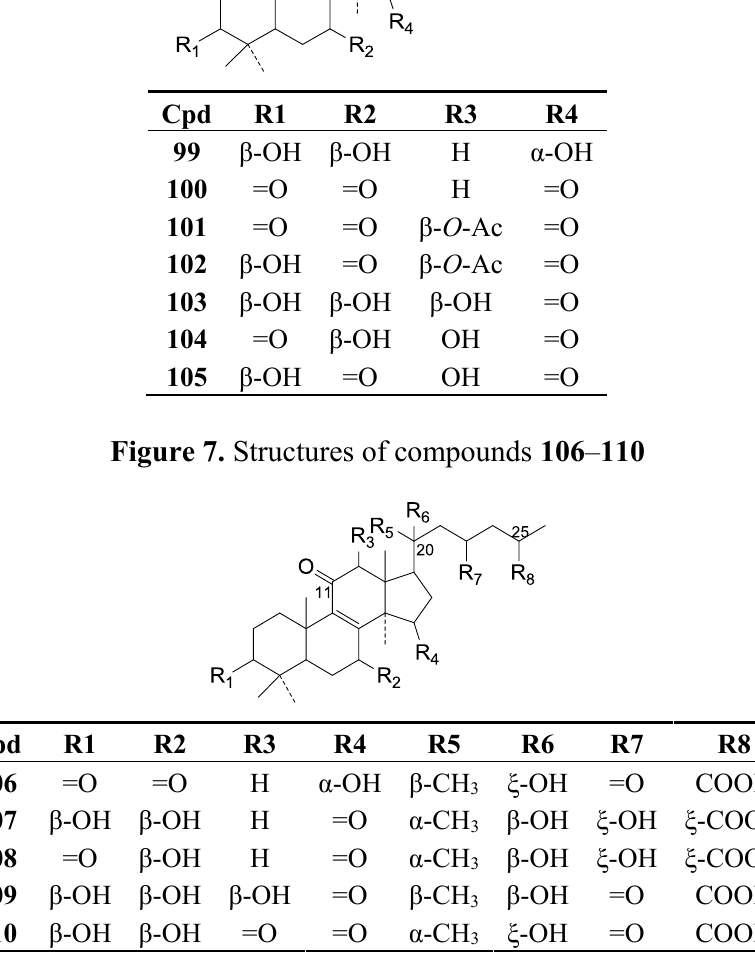
Figure 8. Structures of compounds 111 ‒